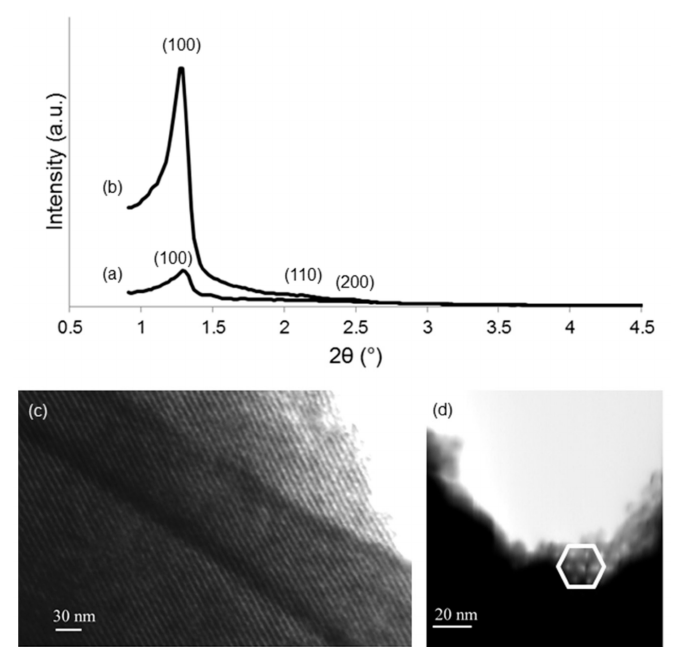
Figure 7. Mesoporous structures of Cu-doped MBGs: (top) small-angle XRD pattern of ( a ) 1Cu-MBG and ( b ) 5Cu-MBG; (bottom) STEM images of 5Cu-MBG recorded along ( c ) [100] and ( d ) [001] directions. In ( d ) the typical hexagonal symmetry of the mesopores is